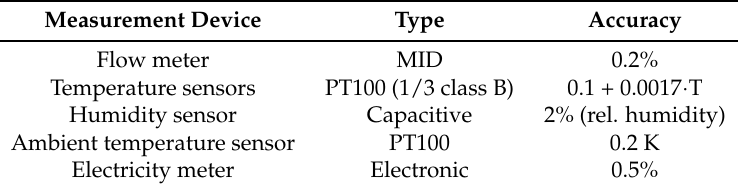
Table 2. Measurement equipment involved in the